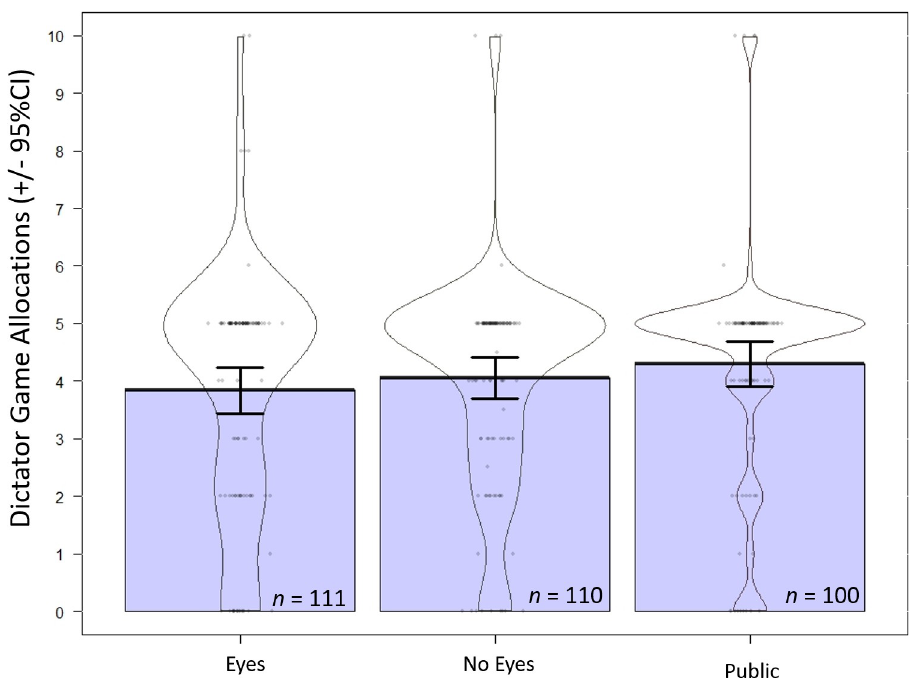
Fig 3. Dictator game allocations by condition (+/- 95% CIs; N = 355). Colored areas represent traditional bar graphs. Contours are violin plots which demonstrate the distribution of responses for that condition. Dots are individual responses, with jitter so they don’t all